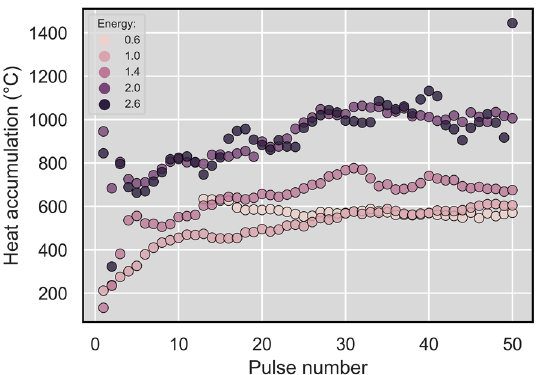
Figure 7. Heat accumulation temperatures for diferent fluences and laser pulses determined from the measurement and